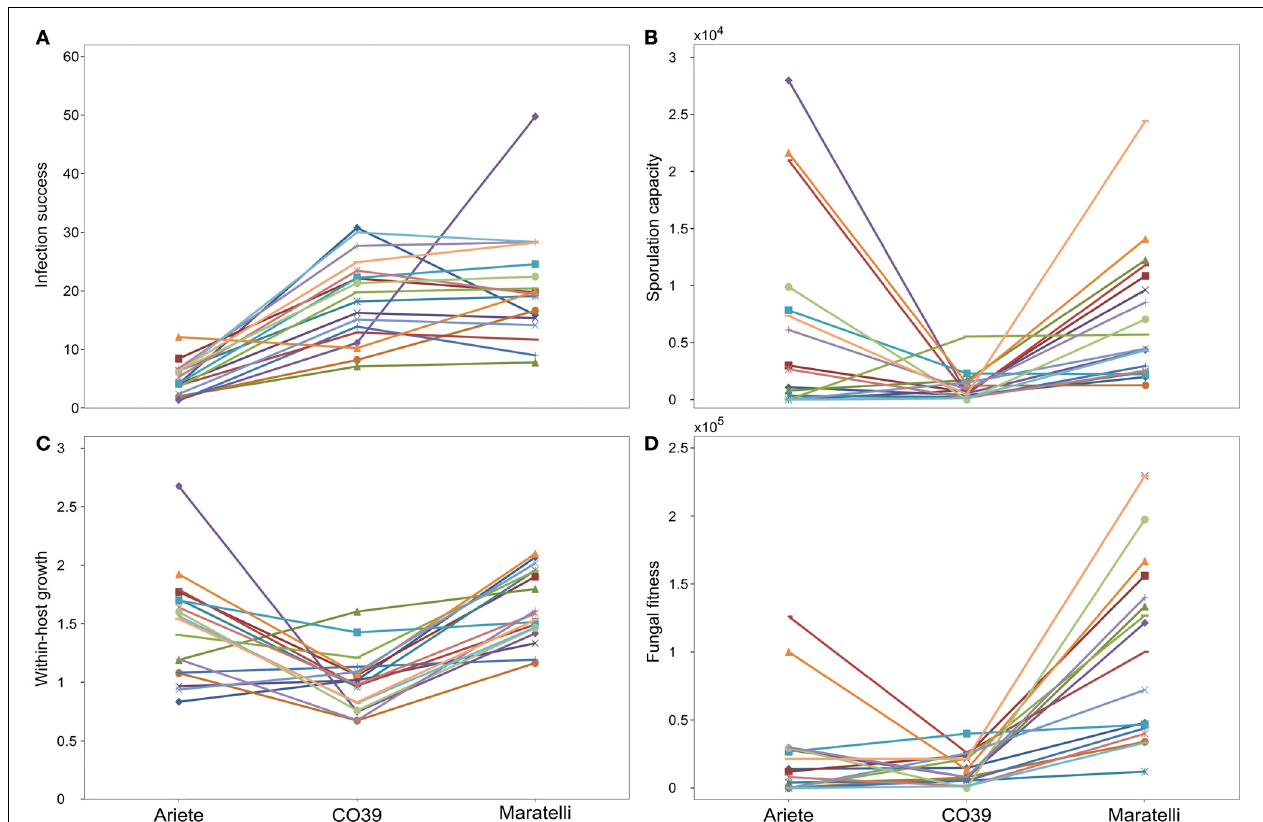
FIGURE 2 | Average performance of the 18 fungal strains on each rice varieties. Panel (A) depicts infection success (average number of lesions observed on three leaves), (B) the sporulation capacity (average number of spores per lesion), (C) the within-host growth (average lesion size), and (D)